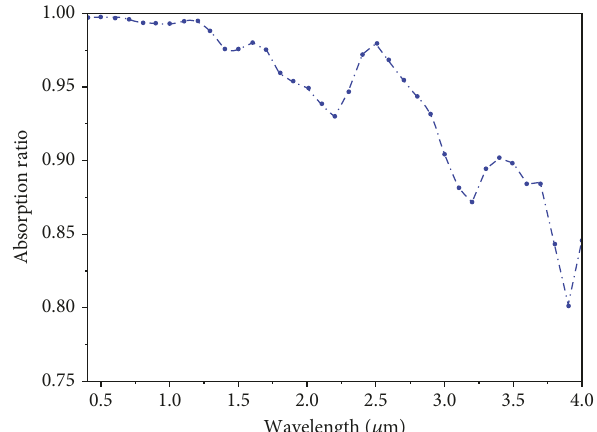
Figure 6: Absorptivity varying curve of V-type groove structure along with wavelength.